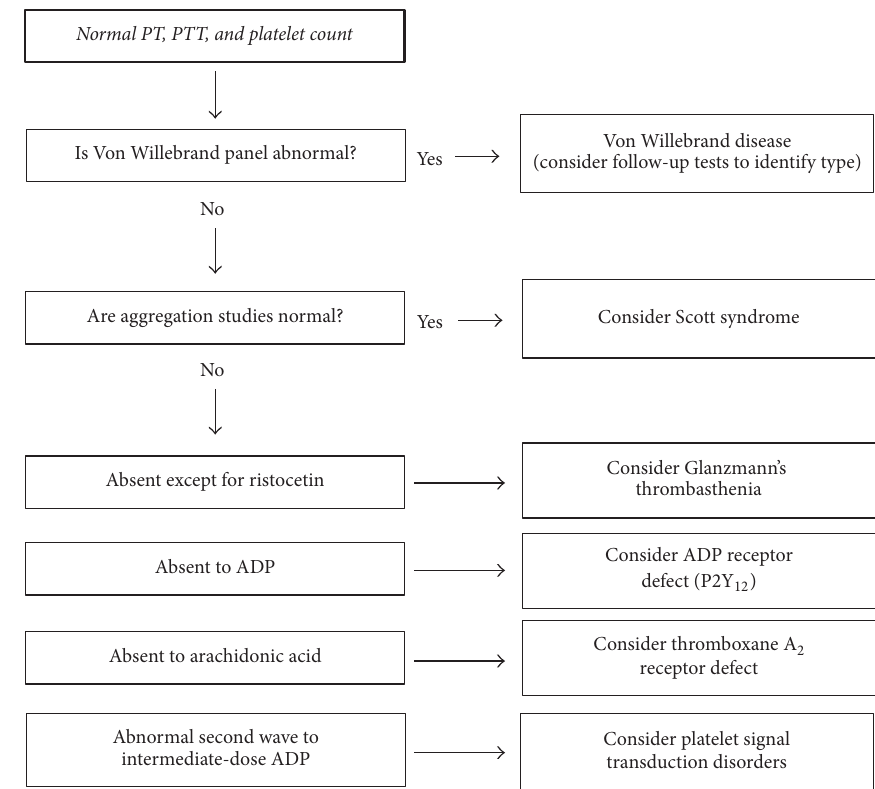
Figure 1: Algorithm for the evaluation and differential diagnosis of bleeding disorders in children presenting with epistaxis and a normal PT, PTT, and platelet count. ADP, adenosine diphosphate; PT, prothrombin time; PTT, partial thromboplastin